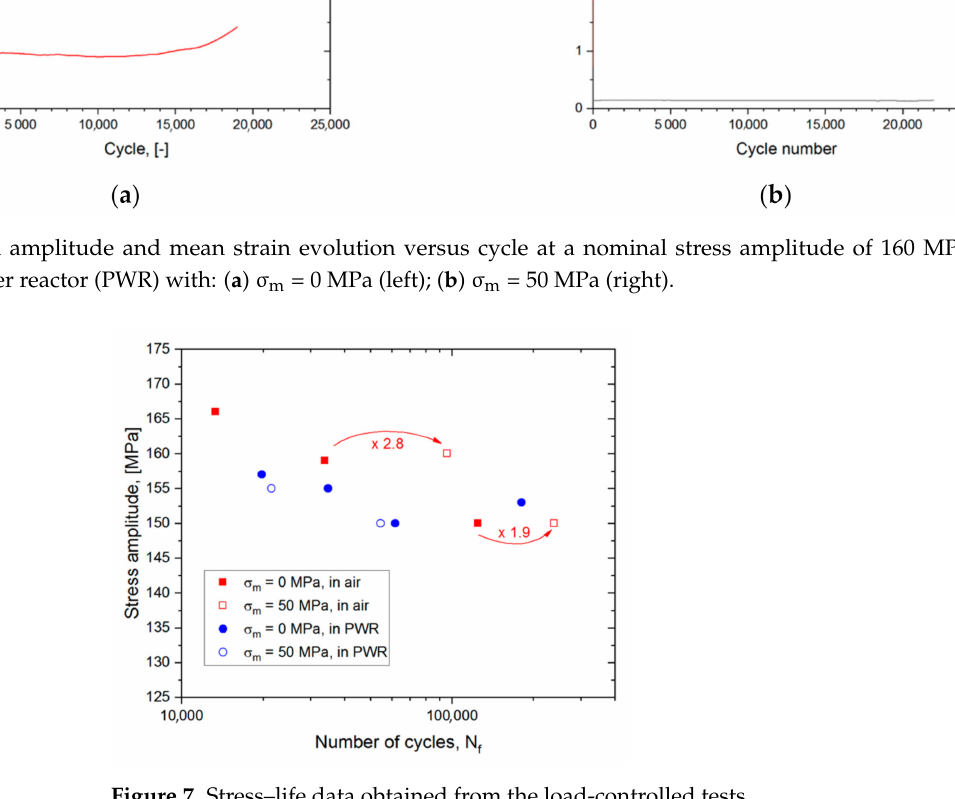
Figure 7. Stress–life data obtained from the load-controlled